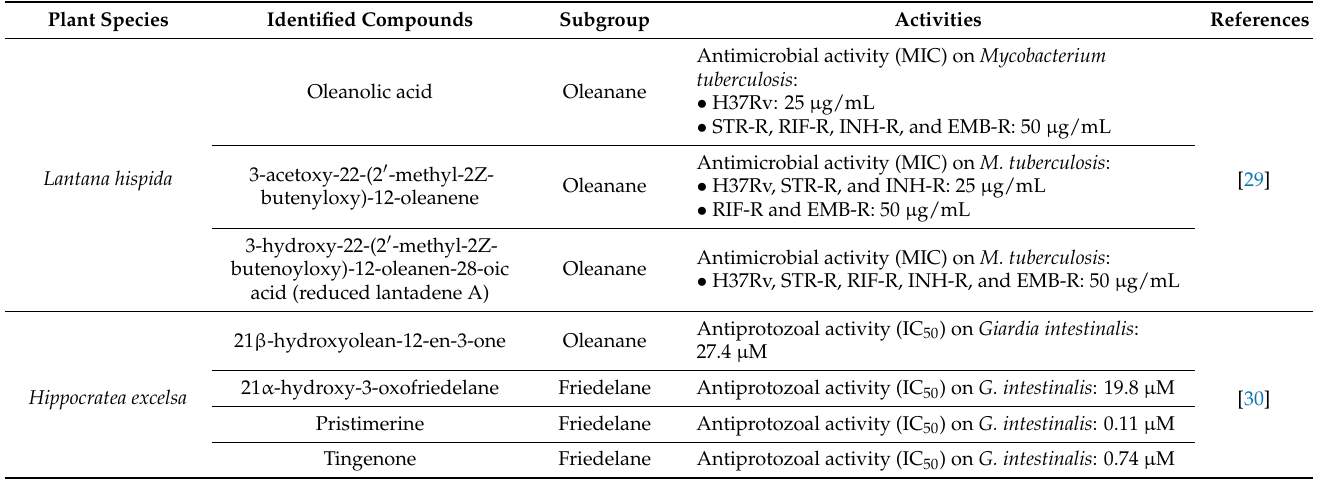
Table 1. PCTs isolated from Mexican plants with biological activity.